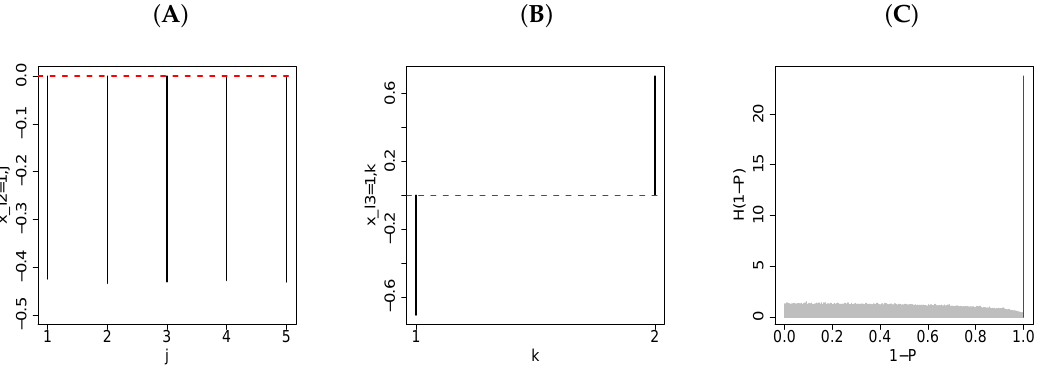
Figure 1. The results on the artificial data: ( A ) x (cid:96) The horizontal red dashed line is x (cid:96) The horizontal red dashed line is x (cid:96) red segment represents the bin with the smallest P